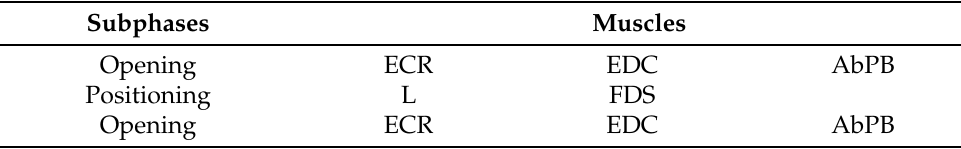
Table 3. Stimulation sequence for forefinger extension.